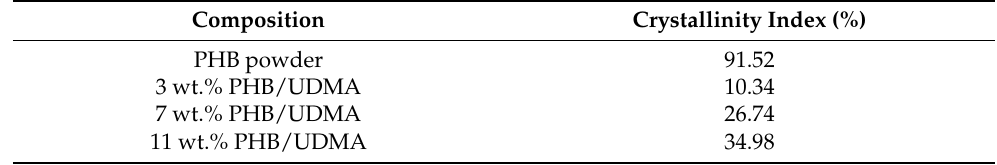
Table 5. Crystallinity index (CI) for PHB powder and 3D printed